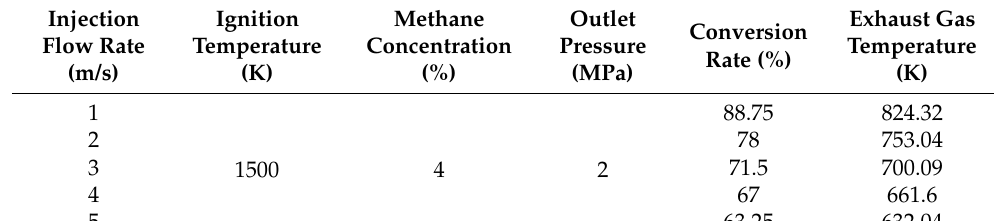
Table 8. Simulation parameters of the influence of injection rate on conversion rate and exhaust gas temperature at 4 MPa, 4% of CH 4.